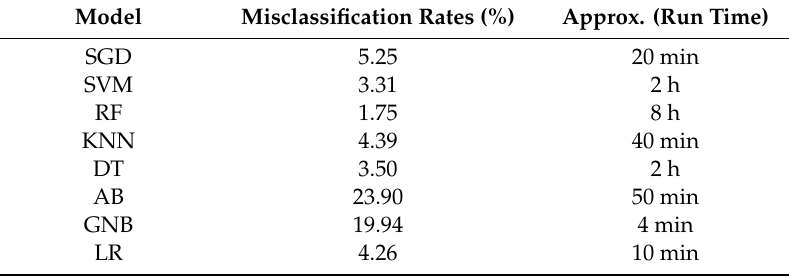
Table 6. Misclassification error rates and model run